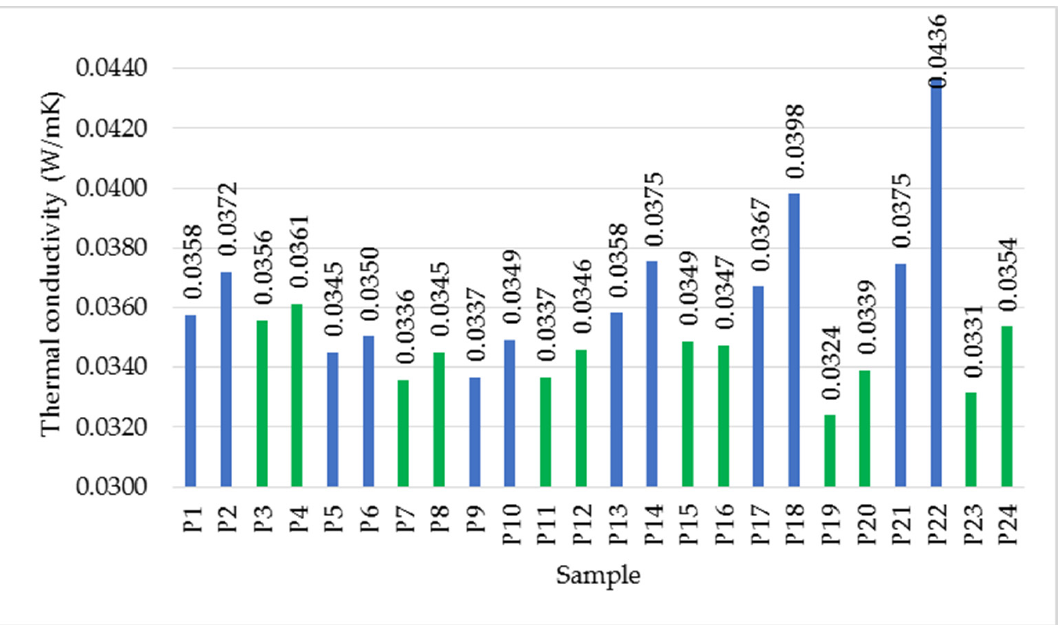
Figure 10. Variation of thermal conductivity, average values. Notation: blue—samples made with resin, green—samples made with latex.